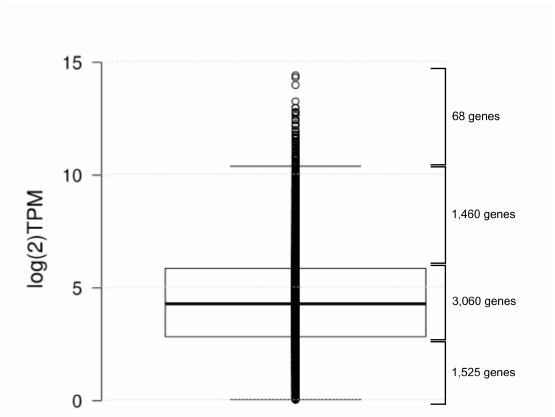
Figure 5. Box-Whisker plot of the log2-transformed Transcript per Million (TPM) values of transcribed genes. The center line shows the median (4.25), box limits indicate the 25th and 75th percentiles as determined by Tukey (2.79 and 5.82, respectively). Whiskers extend up to 1.5 times the interquartile range from the 25th and 75th percentiles (0.00 and 10.35, respectively), data points are plotted as open circles, n = 6113 sample